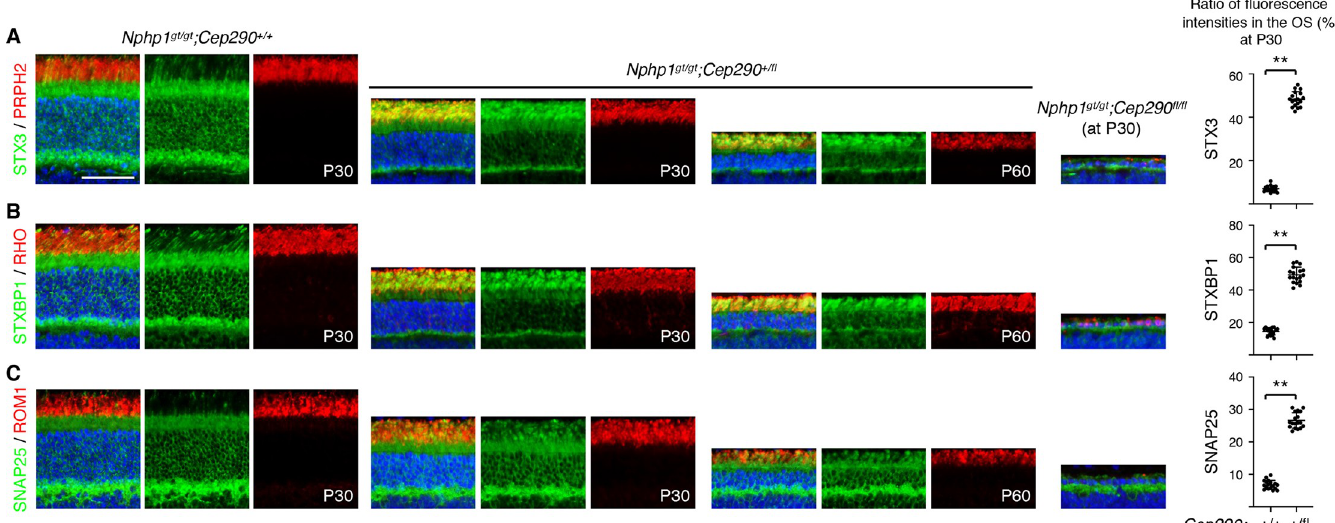
Fig 7. Genetic interaction of Nphp1 with Cep290 . Mislocalization of STX3 (A), STXBP1 (B), and SNAP25 (C) in Nphp gt/gt ;Cep290 +/+ , Nphp gt/gt ;Cep290 +/fl , and Nphp gt/ gt ;Cep290 fl/fl retinas (green). PRPH2, RHO, and ROM1 (red) were labeled to mark the OS. The ratio of mislocalized proteins was quantified as in Fig 1 and depicted on the right. Mean ± SD is marked by horizontal lines (n = 3 mice; 2 sections/mouse and 3 areas/section). Asterisks indicate statistical significance (unpaired, 2-tailed t test; p <